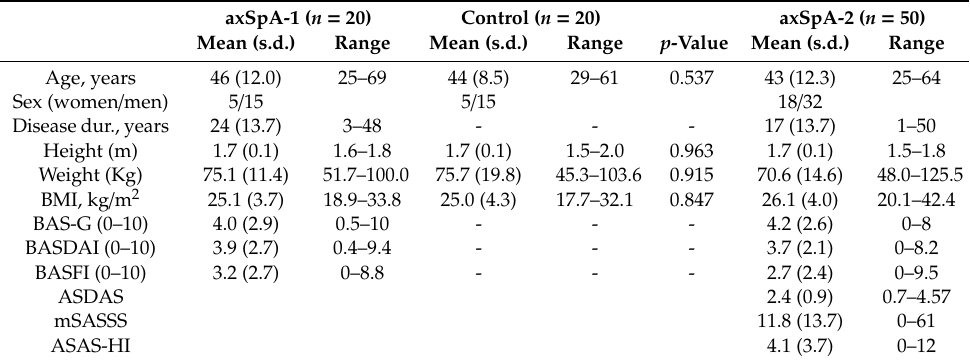
Table 1. Demographics and clinical characteristics of the